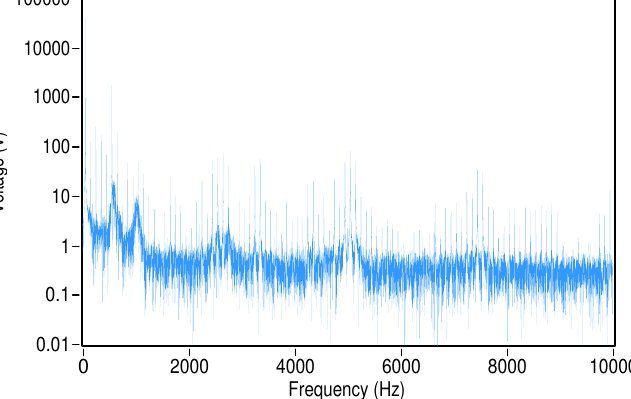
Figure 2. A typical voltage spectrum in 25 kV 50 Hz rail networks.